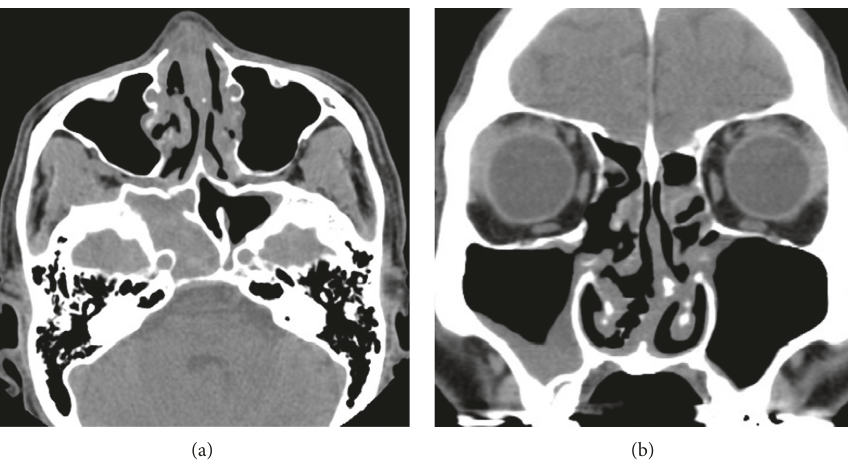
Figure 1: CTscan at first visit shows swelling of the mucosa in the bilateral ethmoid sinuses (a) along with a soft-tissue area occupying the right sphenoid sinus (b).